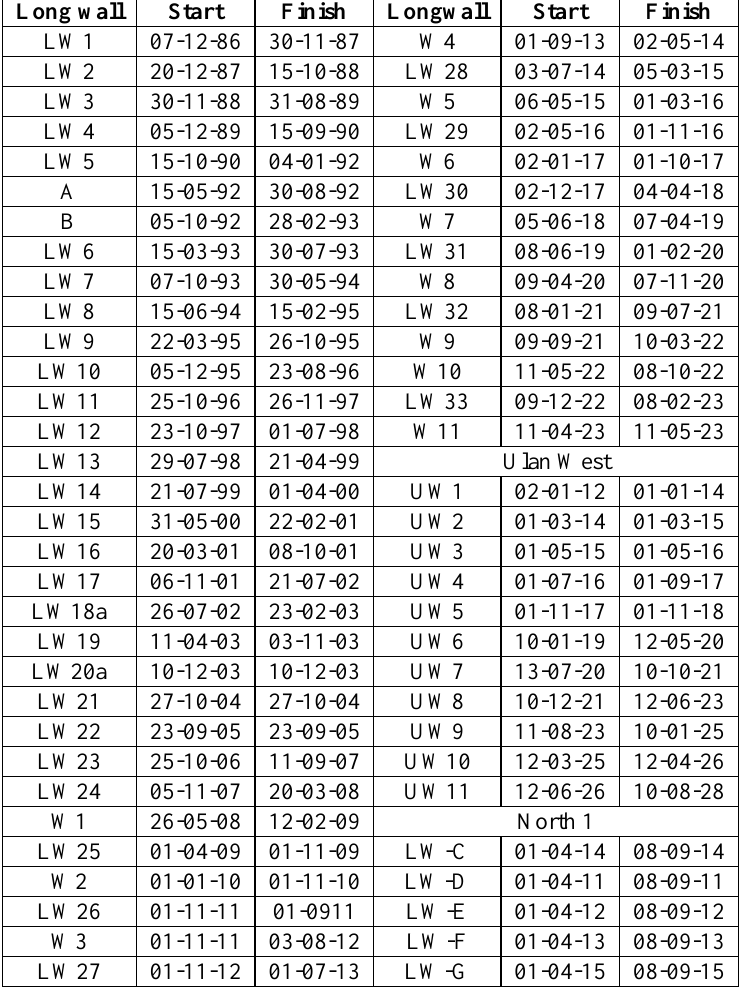
Table 2: Extraction timetable of Ulan longwall